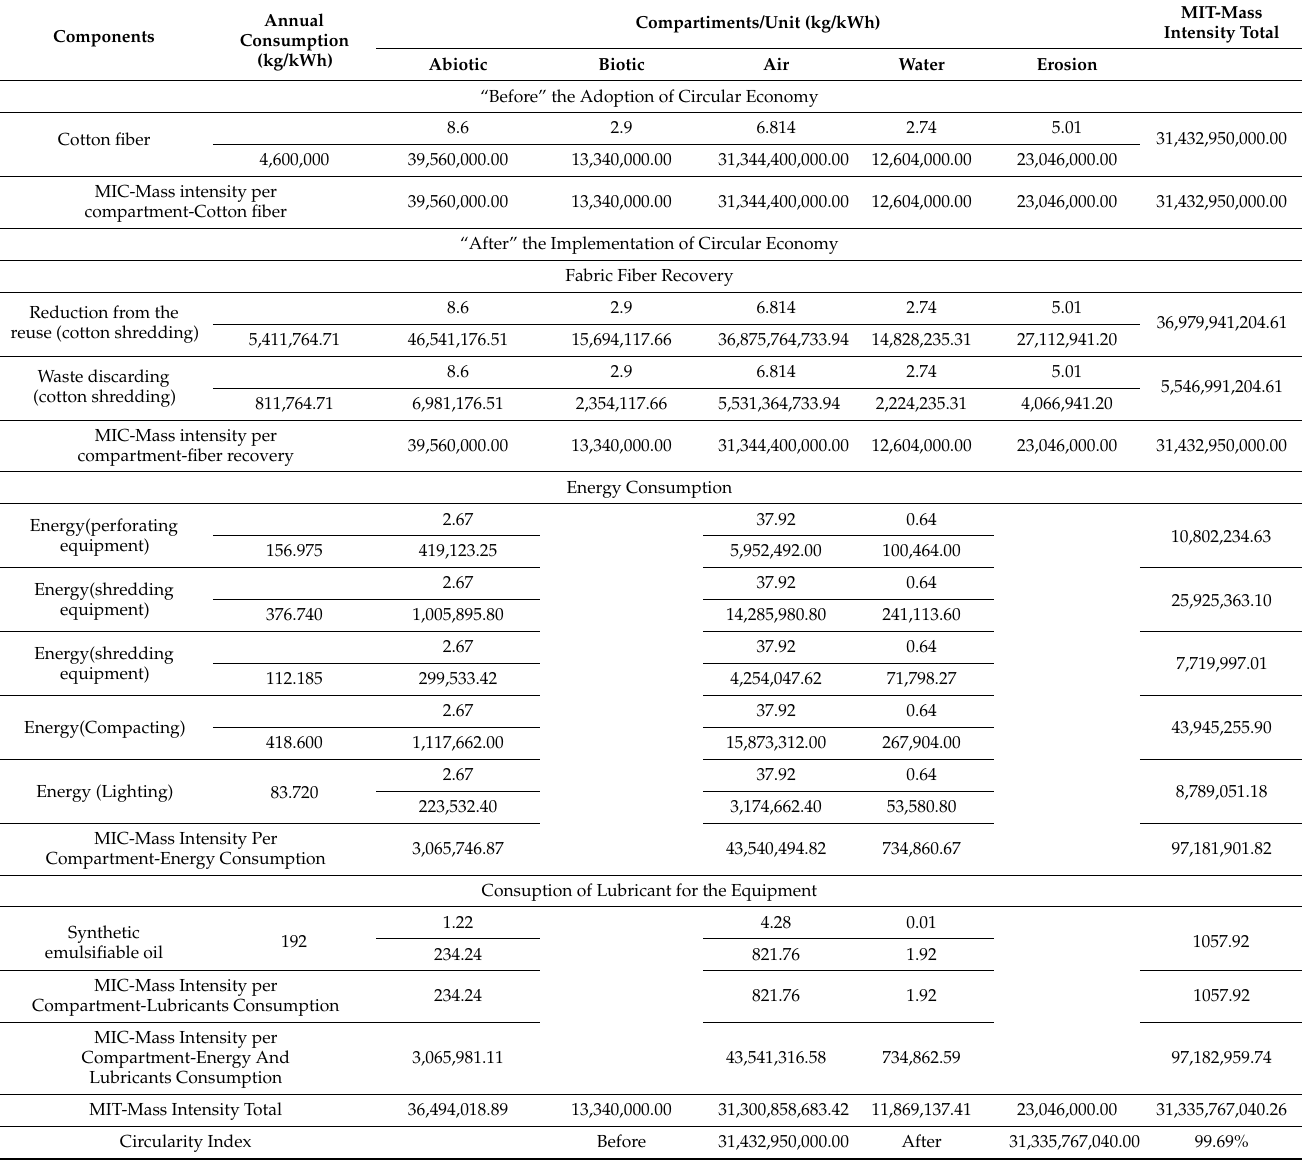
Table 4. Environmental assessment of the process for recovering textile